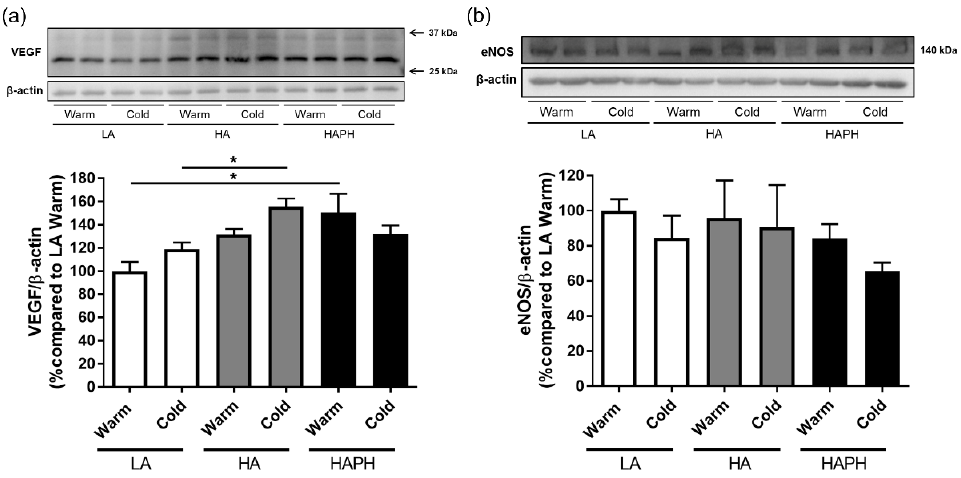
Figure 7. Effects of isolated microparticles (MPs) on human pulmonary artery endothelial cells (PAECs): expression profiles of vascular endothelial growth factor (VEGF) and endothelial nitric oxide synthase (eNOS). Human PAECs are exposed to isolated MPs and their effects on expression profiles of VEGF ( a ) and eNOS ( b ) are analyzed by Western Blot and presented. LA — lowlanders, HA — highlanders, HAPH — highlanders with pulmonary hypertension. Results are presented as mean ± SEM (n = 4). * p < 0.05 values are considered statistically significant.